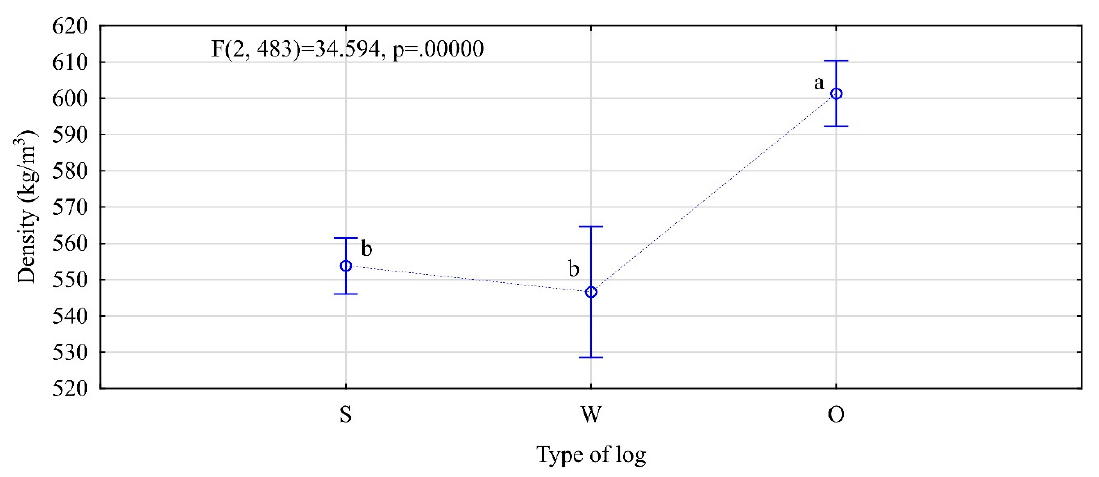
Figure 3. Density of analyzed timber (W—top logs, S—middle logs, O—butt-end logs. The letters denote uniform groups, as determined by Tukey’s HSD (honest significant difference) test).